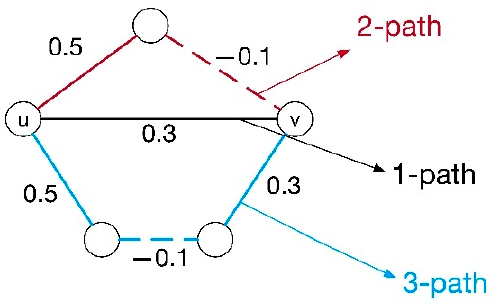
Figure 2. Completing the weight between u and v .